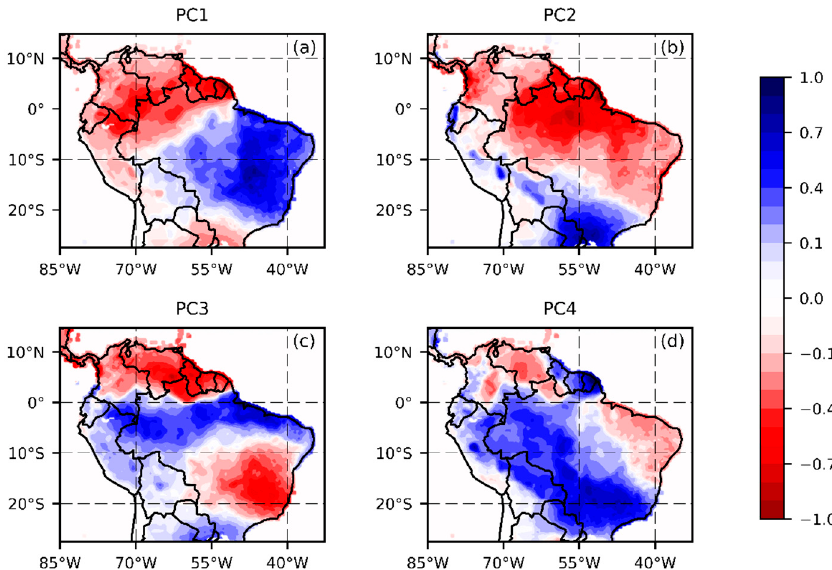
Figure 2. Spatial pattern of the positive phase of the four leading normalized principal components, based on the deseasonalized monthly precipitation from the GPCC dataset for the period 1931–2010. Blue colors are related to positive precipitation anomalies; red colors are related to negative precipitation anomalies. ( a ) PC1, ( b ) PC3, ( c ) PC3, and ( d ) PC4.